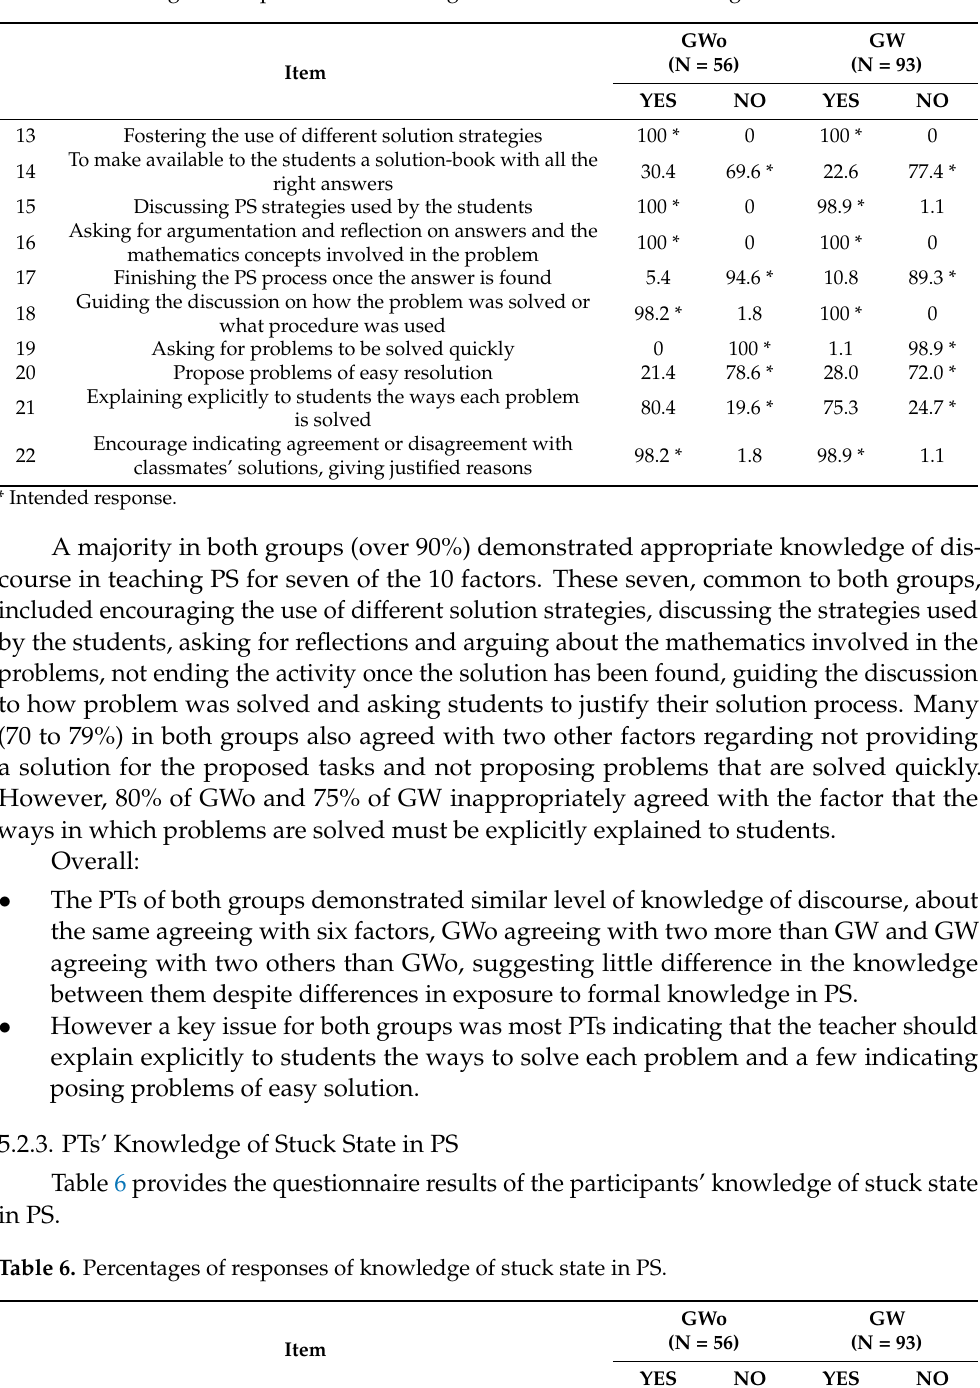
Table 5. Percentages of responses of knowledge of discourse in PS teaching.